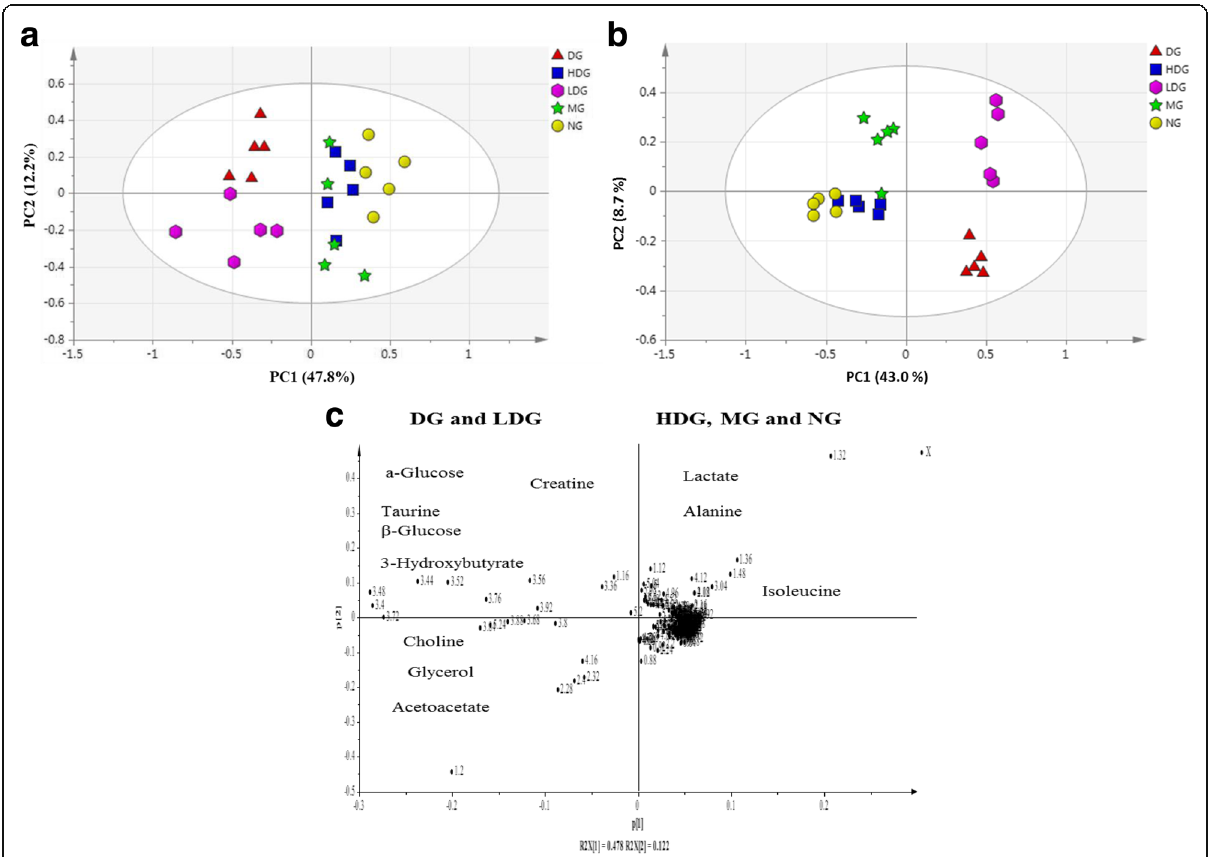
Fig. 8 PCA score plot ( a ), OPLS-DA score ( b ) and PCA Loading plot ( c ) obtained using 1 H NMR data for serum samples from Sprague-Dawley rats, obese diabetic group (DG), normal diet group (NG), metformin group (MG), low dose group (LDG) or high dose group (HDG) at week8 of